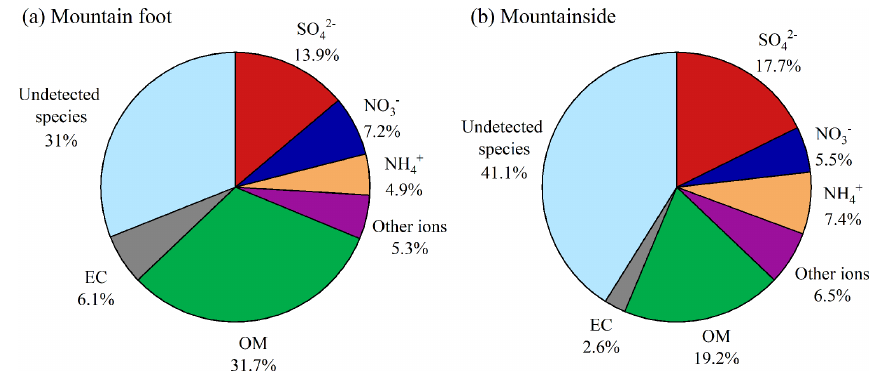
Figure 6. Mass closure of PM 2 . 5 during the observed period (OM = 1 . 6 ×